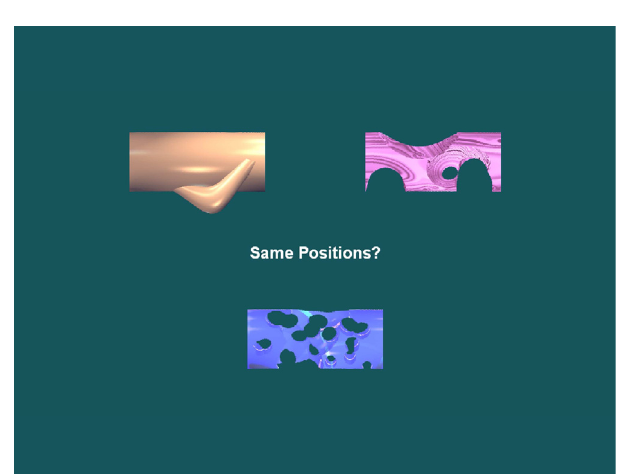
Figure 6 | A sample manipulated spatial relations test trial based on Figure